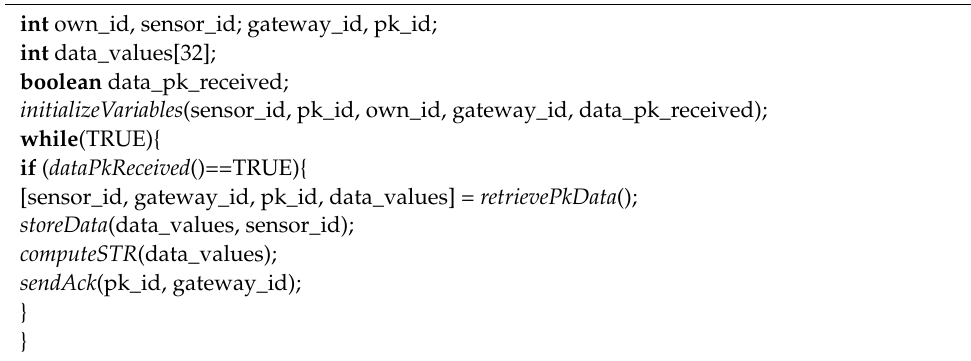
Algorithm A3: Control Center Application